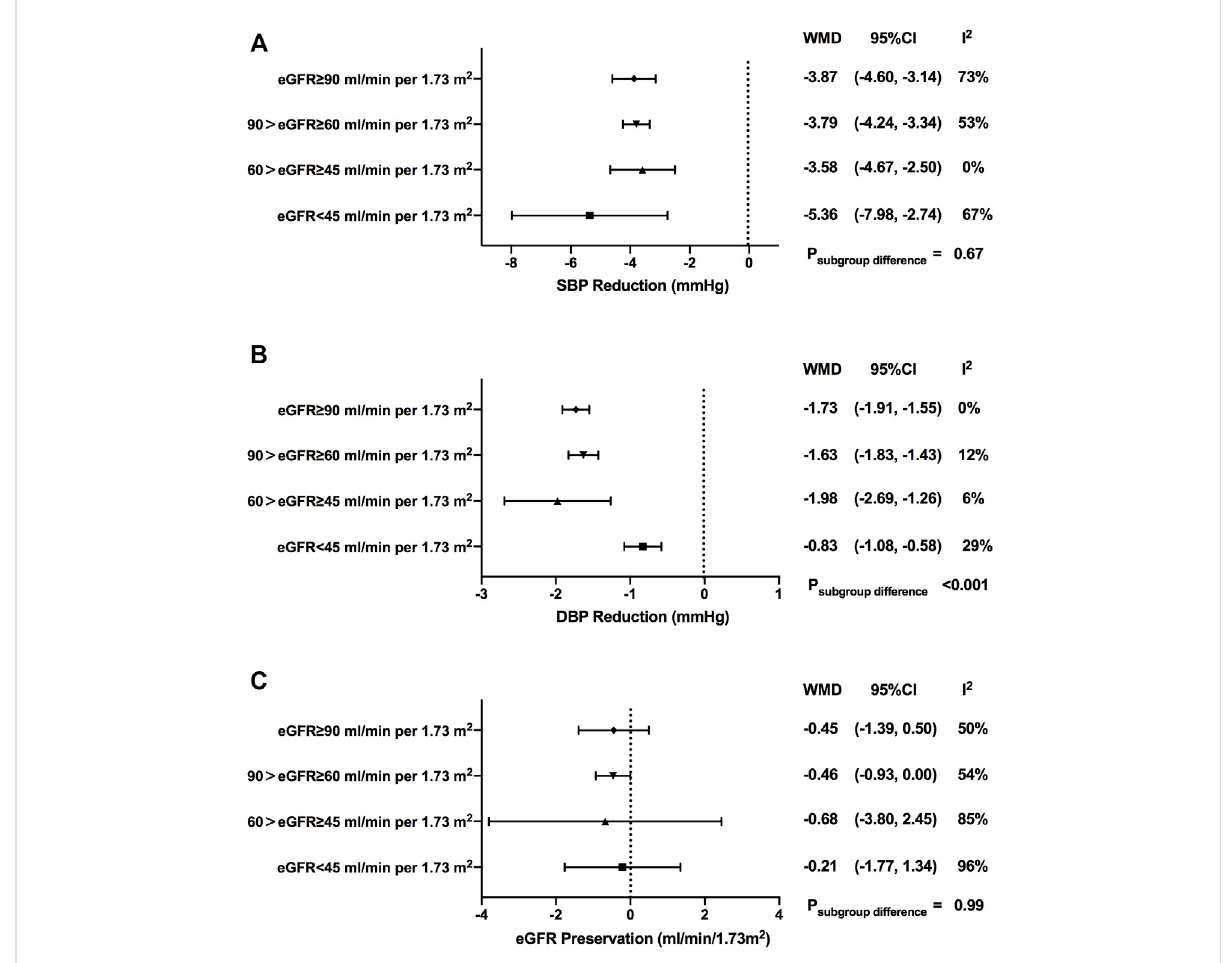
FIGURE 3 Blood pressure and eGFR changes of SGLT2i treatment in patients with different levels of renal function. SBP, systolic blood pressure; DBP, diastolic blood pressure; eGFR, estimated glomerular fi ltrationrate; WMD, weighted mean differences; 95% CIs, 95% con fi dence intervals.